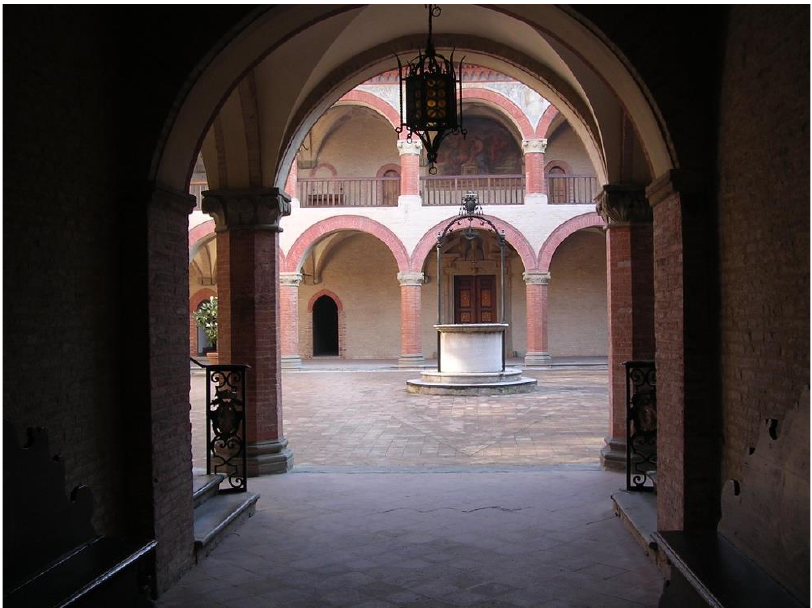
Figure 2. Interior view of the Porticum and Loggia of the Royal Spanish College at the University of